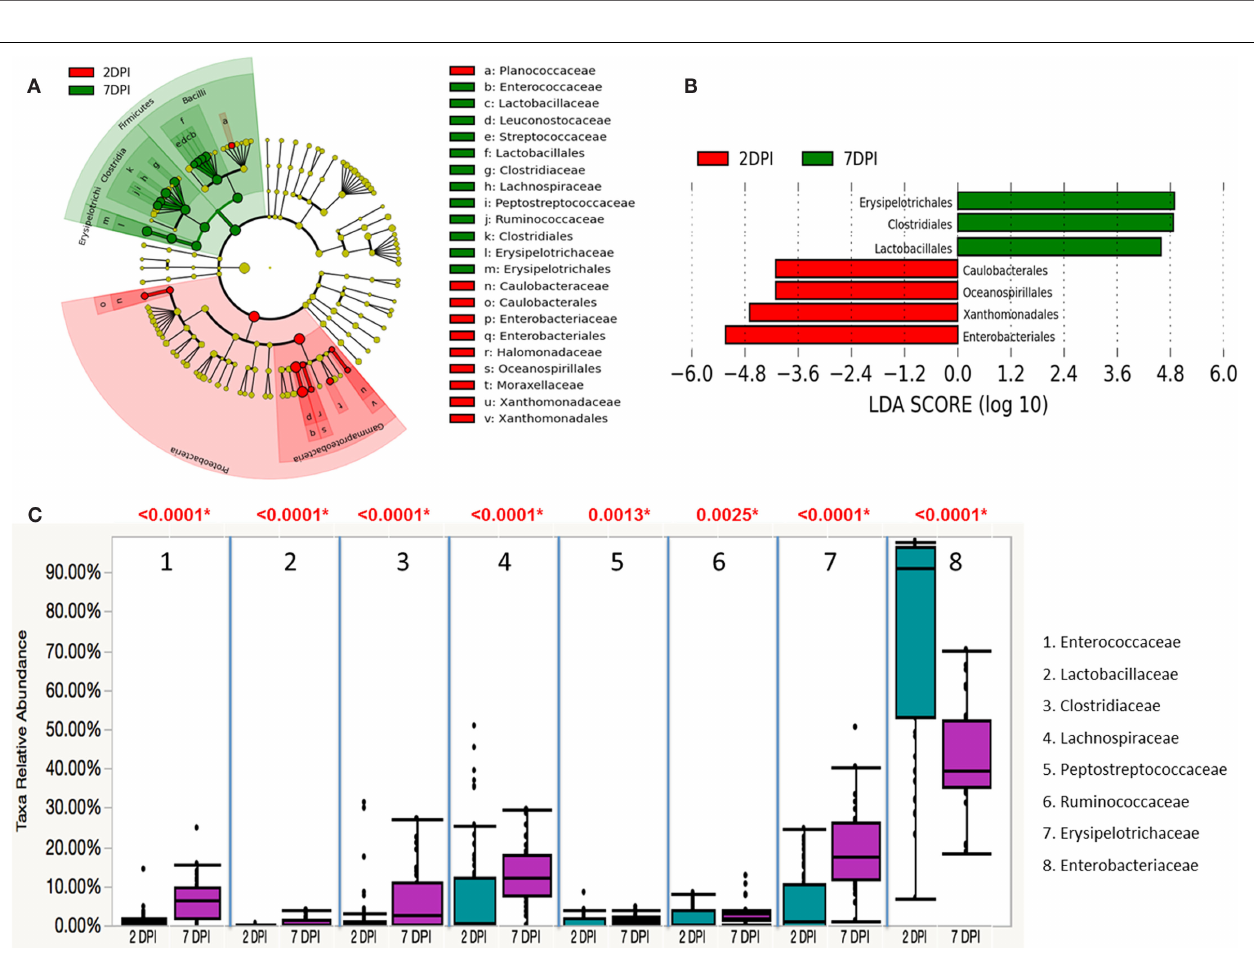
FIGURE 6 | Differential abundances of cecal microbial communities between two postinfection times of S. Enteritidis-infected chicks . (A) Taxonomic cladogram generated from LefSe analysis showing significant difference in microbiota profile of 2DPI (red) and 7DPI (green). (B) Differently abundant taxa detected with cut-off value of linear discriminant analysis (LDA) score > 2.0. Enriched taxa in 2DPI group are indicated with negative LDA score (red) and taxa enriched in 7DPI have positive LDA score (green). (C) Comparison of relative abundance levels of cecal microbiota at family level in S. Enteritidis-infected chicks between two postinfection times was evaluated. The boxplot shows the quartiles above and below the median with dark line at center of the box denoting median, black dots showing the outlier. The respective p value for each family group is reported using Wilcoxon rank sum test. Abbreviations: 2DPI; 2days post infection, 7DPI; 7days post